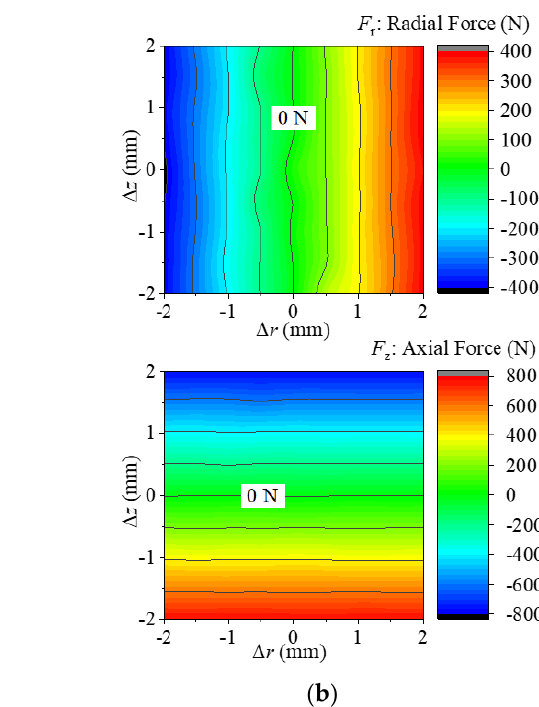
Figure 5. The simulation of unbalanced force on Coil 1 caused by the misalignment of two coils. ( a ) Schematic diagram of misalignment in coils. ( b ) Simulation results of the radial and axial unbalanced force between two coils.